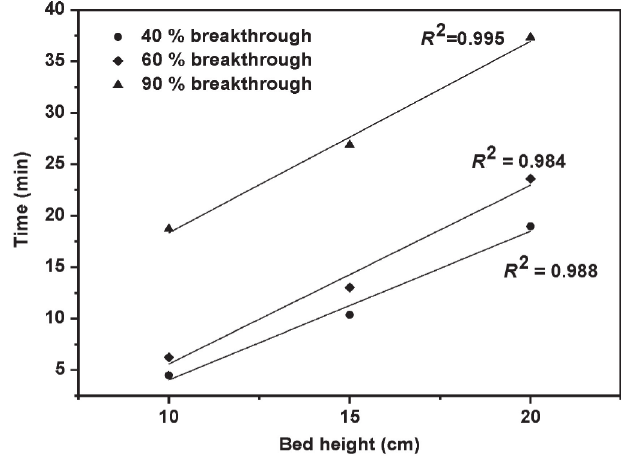
Fig. 5 – Time for breakthrough compared to bed height for acrylic acid adsorption onto CaO column (BDST